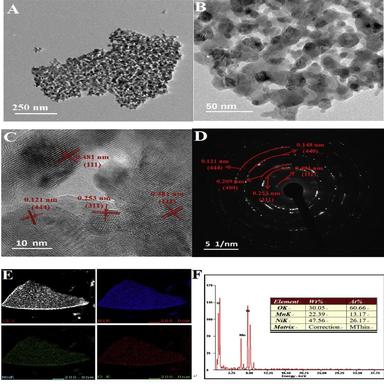
(A, B) Typical low- and high-magnification TEM images, (C) HRTEM images, (D) SAED pattern, (E) elemental mapping analysis of an individual MnNi2O4 nanosheet, and (F) EDX spectrum.